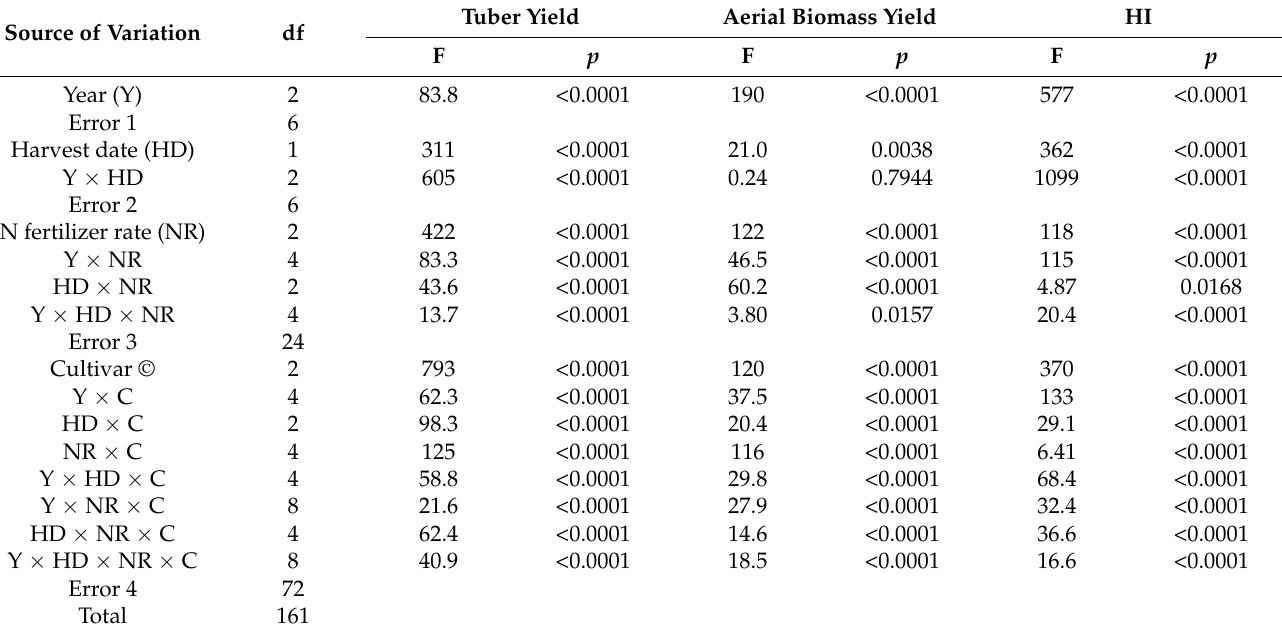
Table 3. Results of a multifactorial (multivariate) analysis of variance (split-split-plot design) for the tuber yield and harvest index of Jerusalem artichoke.